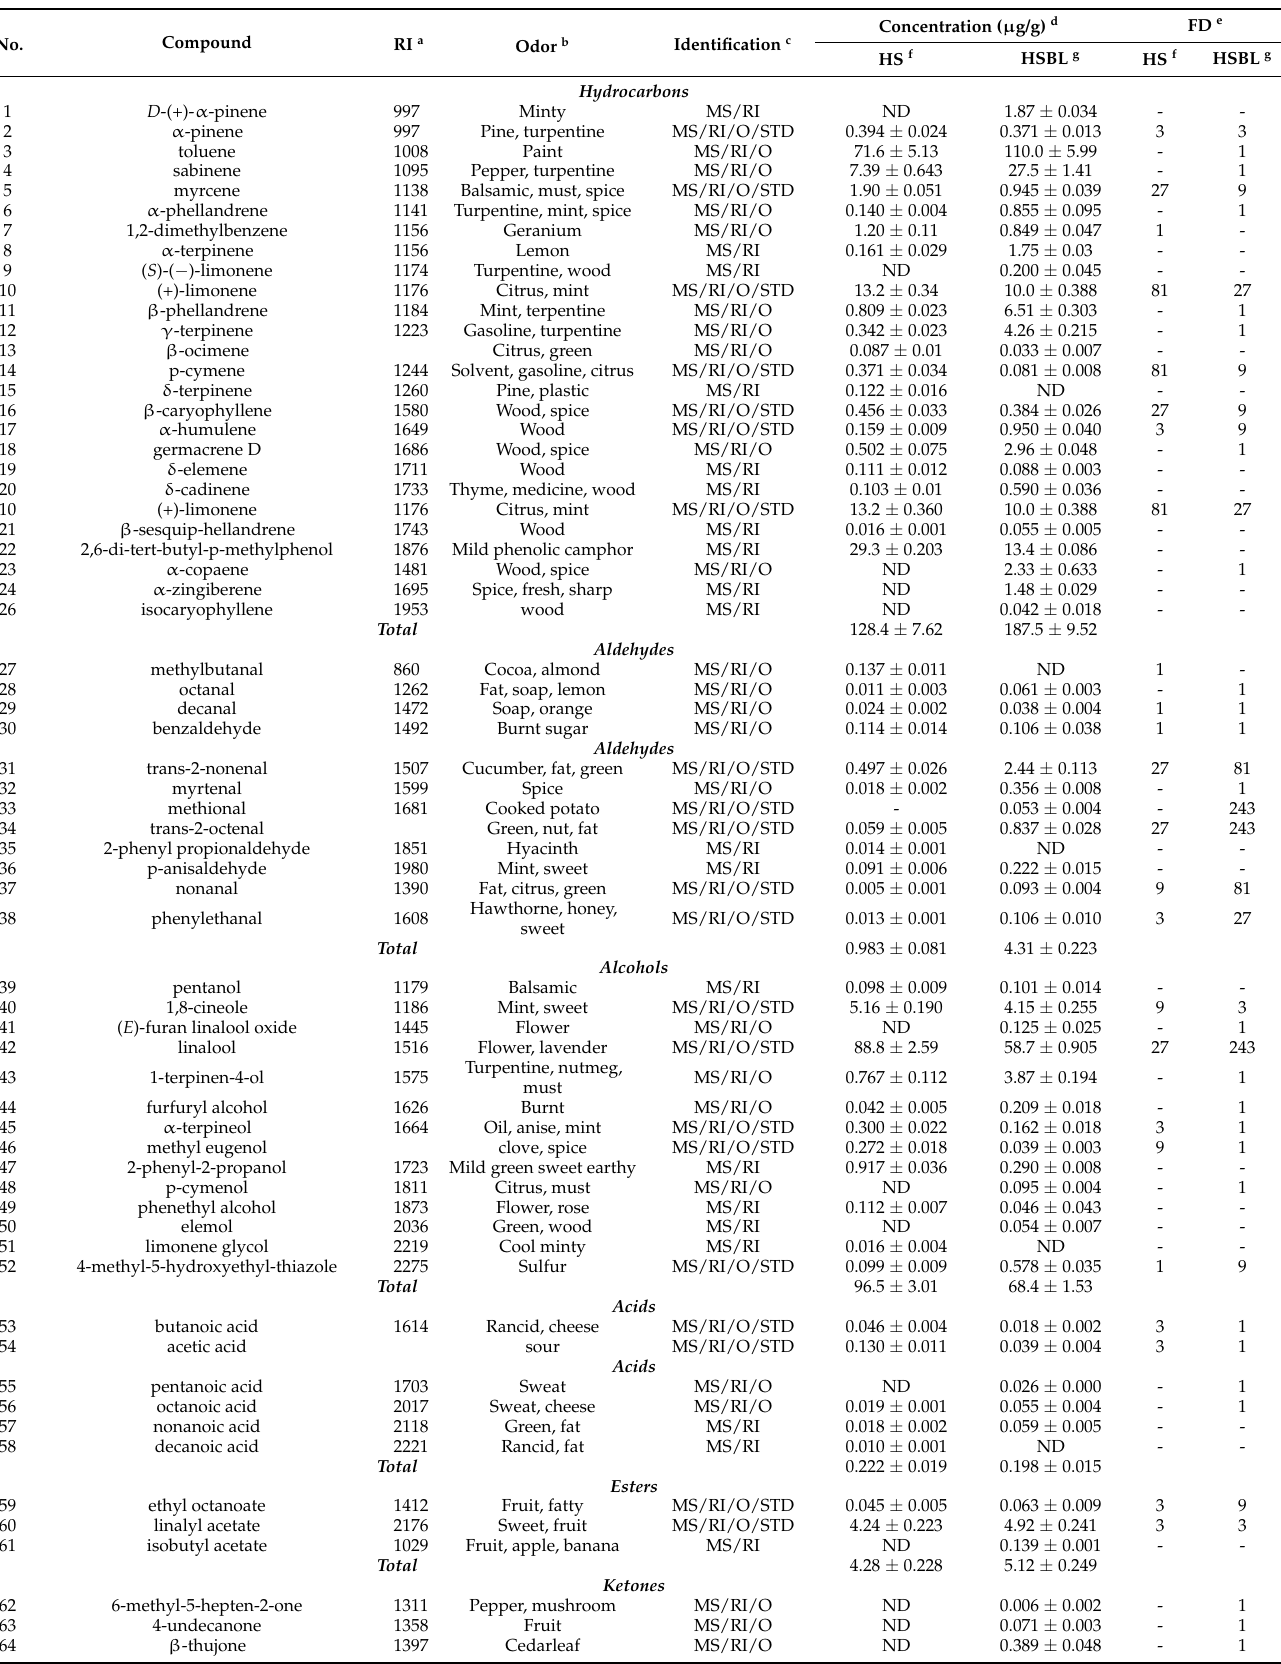
Table 1. Aroma compounds in hotpot seasoning before and after